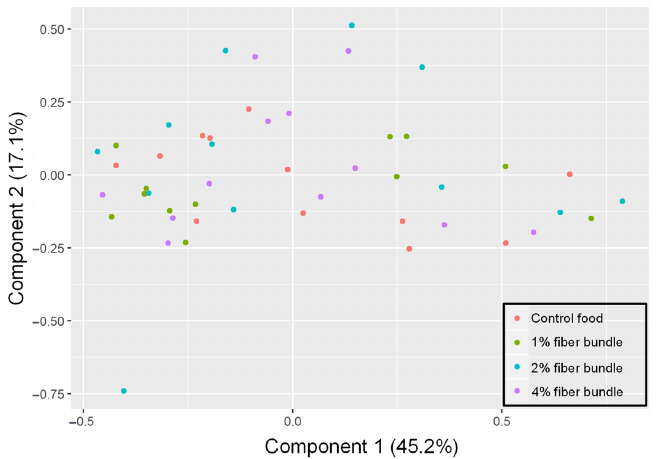
Figure 2. Principal coordinate analysis plot of the fecal microbiome of dogs that consumed foods containing 0%, 1%, 2%, or 4% of added fiber-bound polyphenol ingredients for 31 days. Table 6. PERMANOVA analysis of bacterial taxa and KEGG pathways in feces from dogs that consumed the study foods. Microbiome